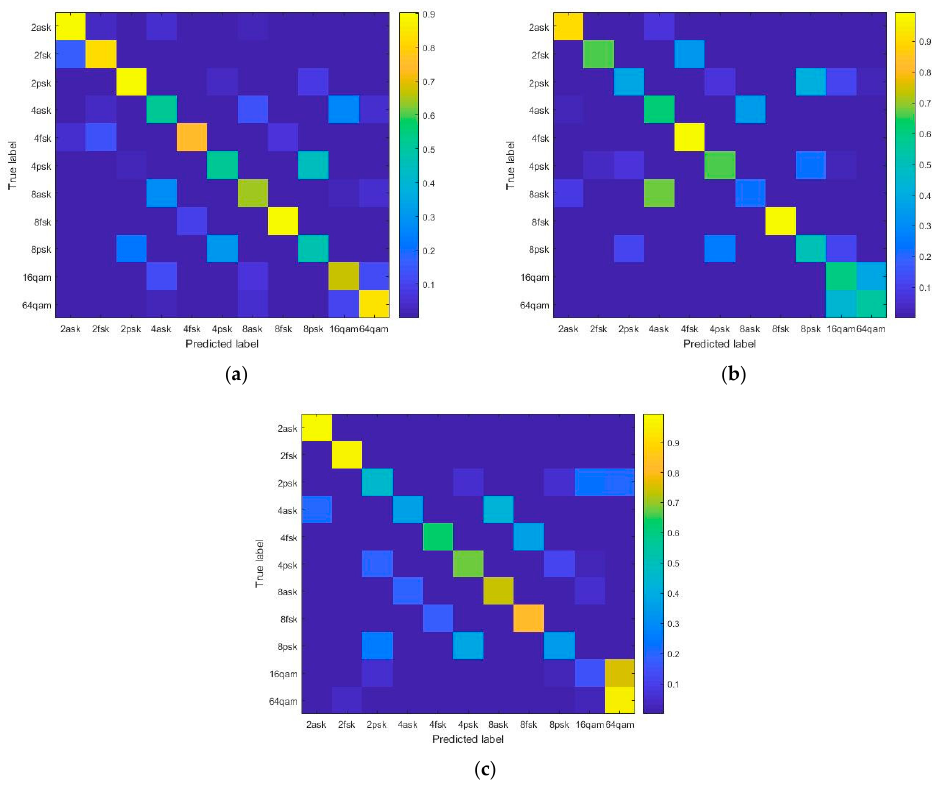
Figure 7. Probability matrix of series fusion model. ( a ) Probability matrix of series fusion model for 20 dB SNR; ( b ) Probability matrix of series fusion model for 10 dB SNR; ( c ) Probability matrix of series fusion model for 0 dB SNR.